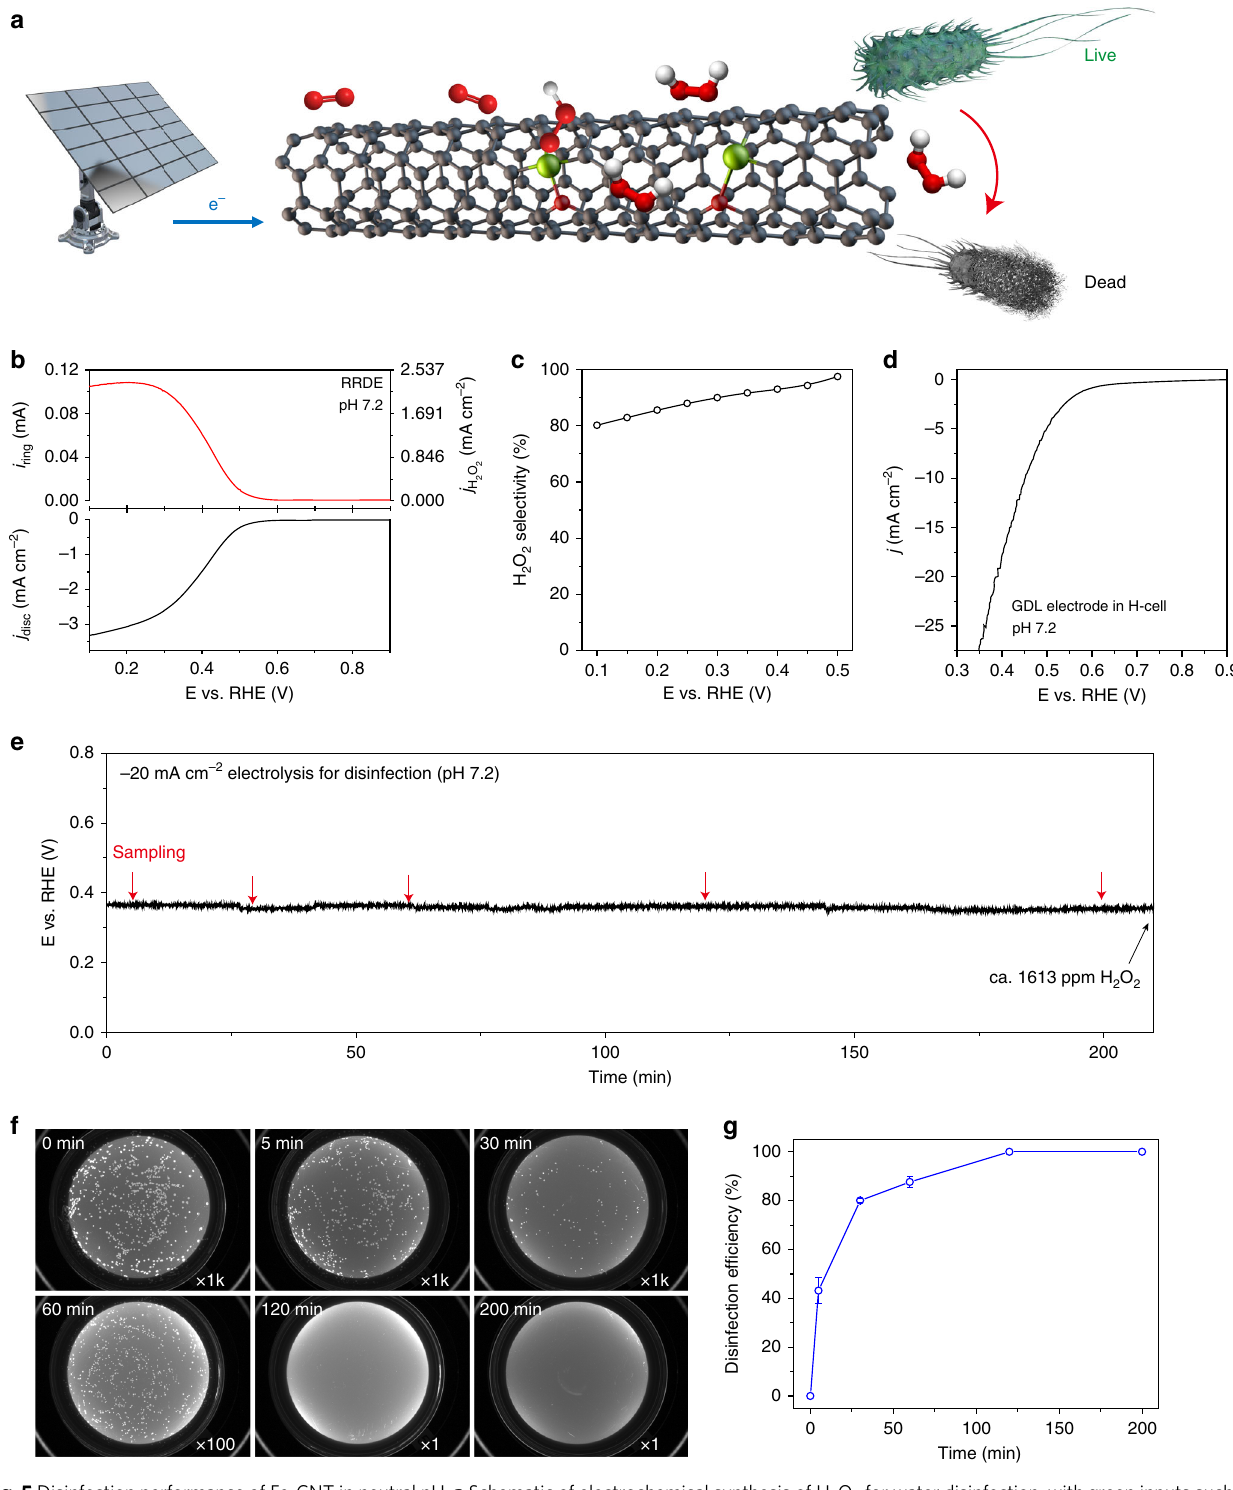
Fig. 5 Disinfection performance of Fe-CNT in neutral pH. a Schematic of electrochemical synthesis of H 2 O 2 for water disinfection, with green inputs such as sunlight, air, and water. b , c LSV of Fe-CNT catalyst on RRDE at 1600 rpm in 0.1 M PBS (pH 7.2) with the corresponding H 2 O 2 selectivity under different potentials. d LSV of Fe-CNT catalyst on GDL electrode (0.5 mg cm − 2 mass loading) in an H-cell electrolyzer. e Bulk electrolysis at a constant current density of 20 mA cm − 2 in 0.1 M PBS containing ~10 7 c.f.u. mL − 1 E coli bacteria. The H 2 O 2 concentration of 1613 ppm at 210 min was determined from a bacteria-free control experiment. f CCD photos of overnight cultured plates with spread droplets taken from different time slots during the electrolysis. Dilution factor is labeled at the right bottom corner of each image. No bacteria colonies were observed after 2-h treatment. g The disinfection ef fi ciency as a function of treatment time. The error bar represents two identical cultured